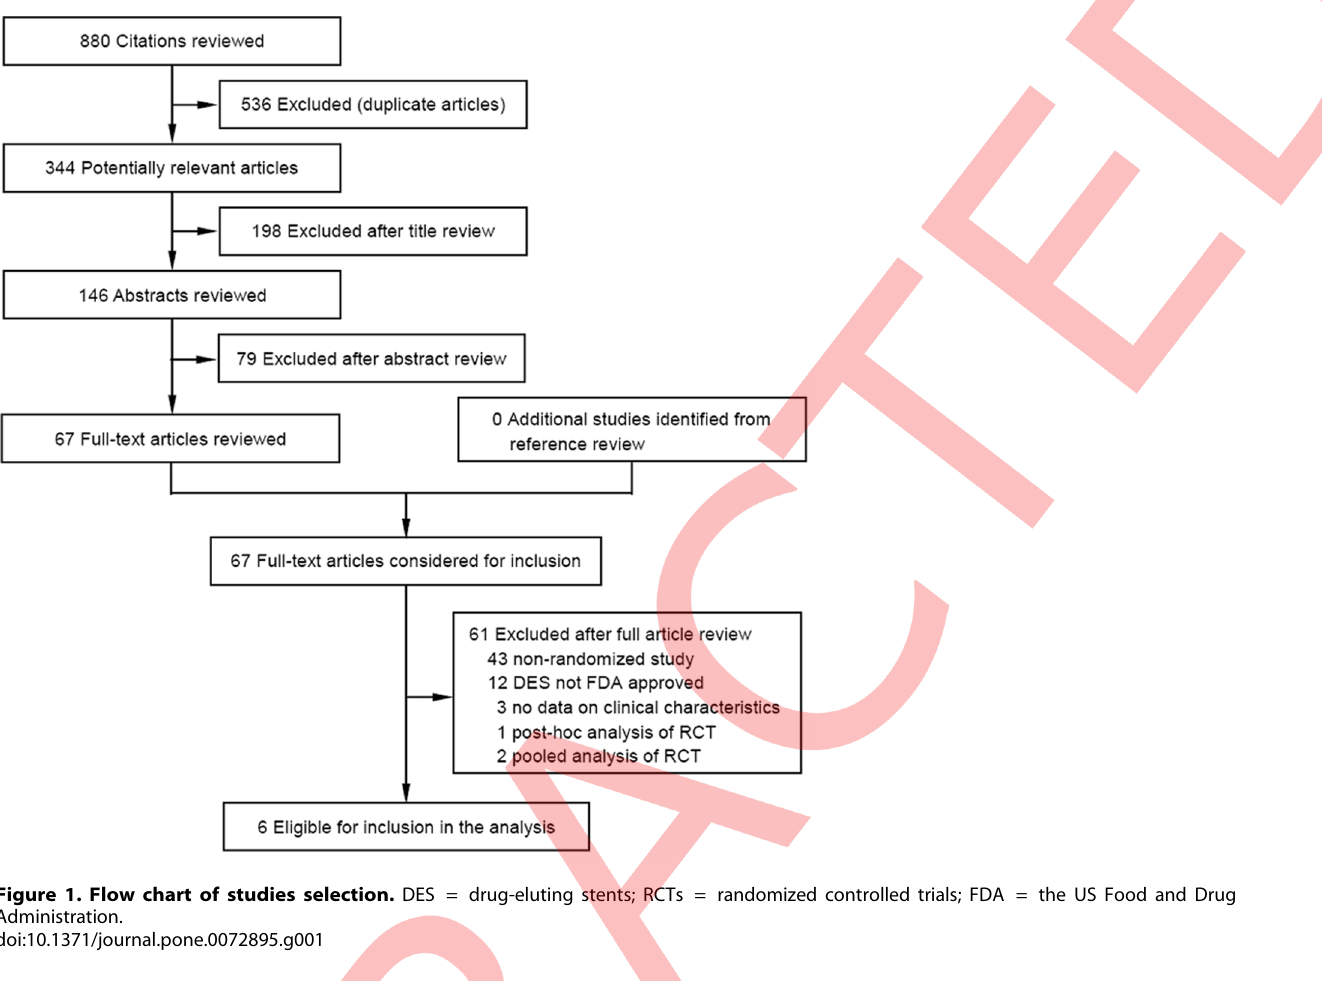
Figure 1. Flow chart of studies selection. DES = drug-eluting stents; RCTs = randomized controlled trials; FDA = the US Food and Drug Administration.